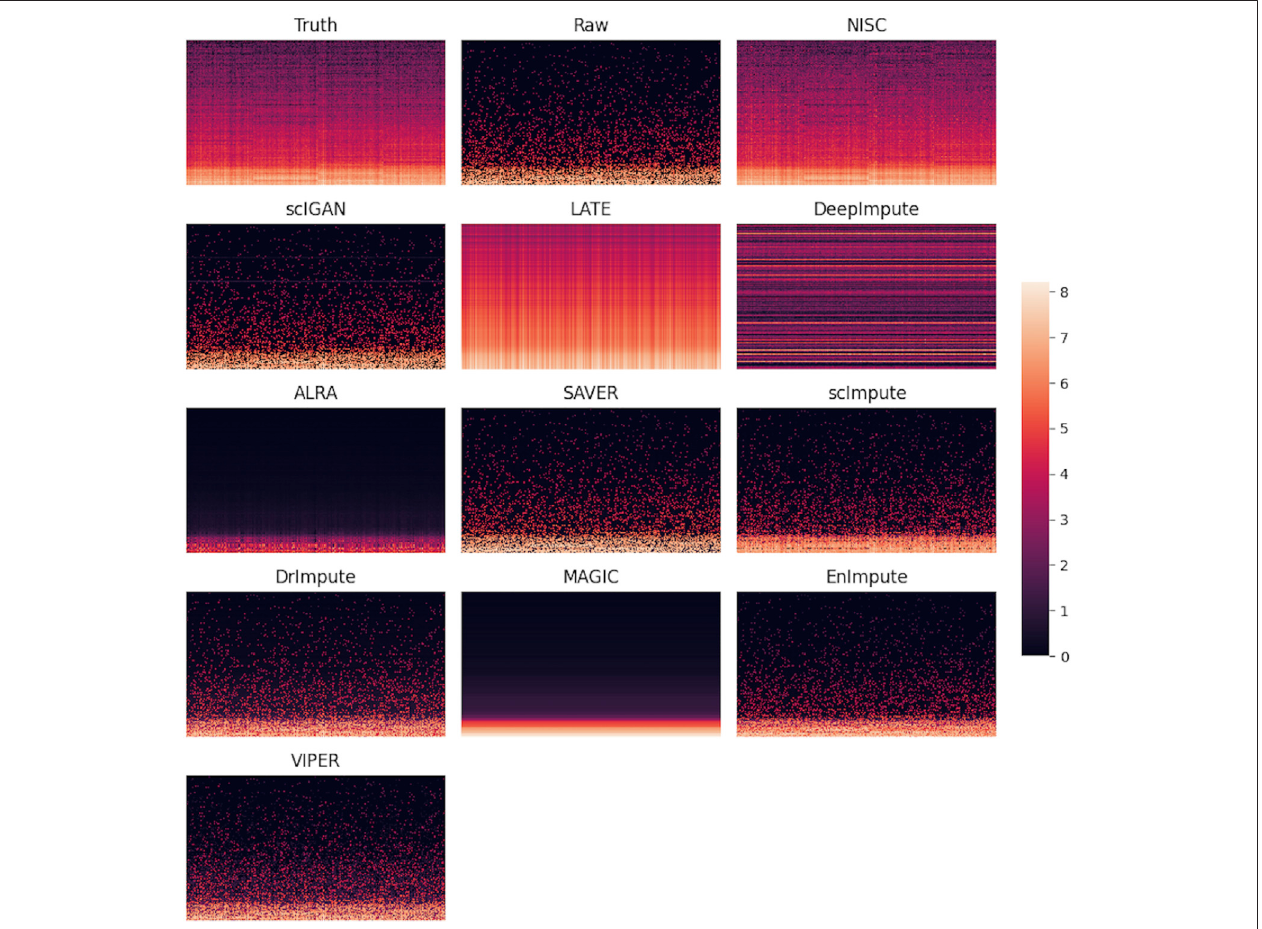
FIGURE5 | Heatmaps ofground truth, raw simulated data,and imputed data by various methods. The simulated raw dataset contains 800genesand 1,000 cells in4 celltypes,with90%sparsity.Eachrowintheheatmaprepresentsagene,whileeachcolumnrepresentsacell.Thecolorbarshowsthemagnitudeofthelogarithmof gene expression